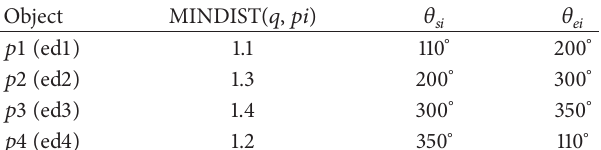
Table 1: Start and end angles.